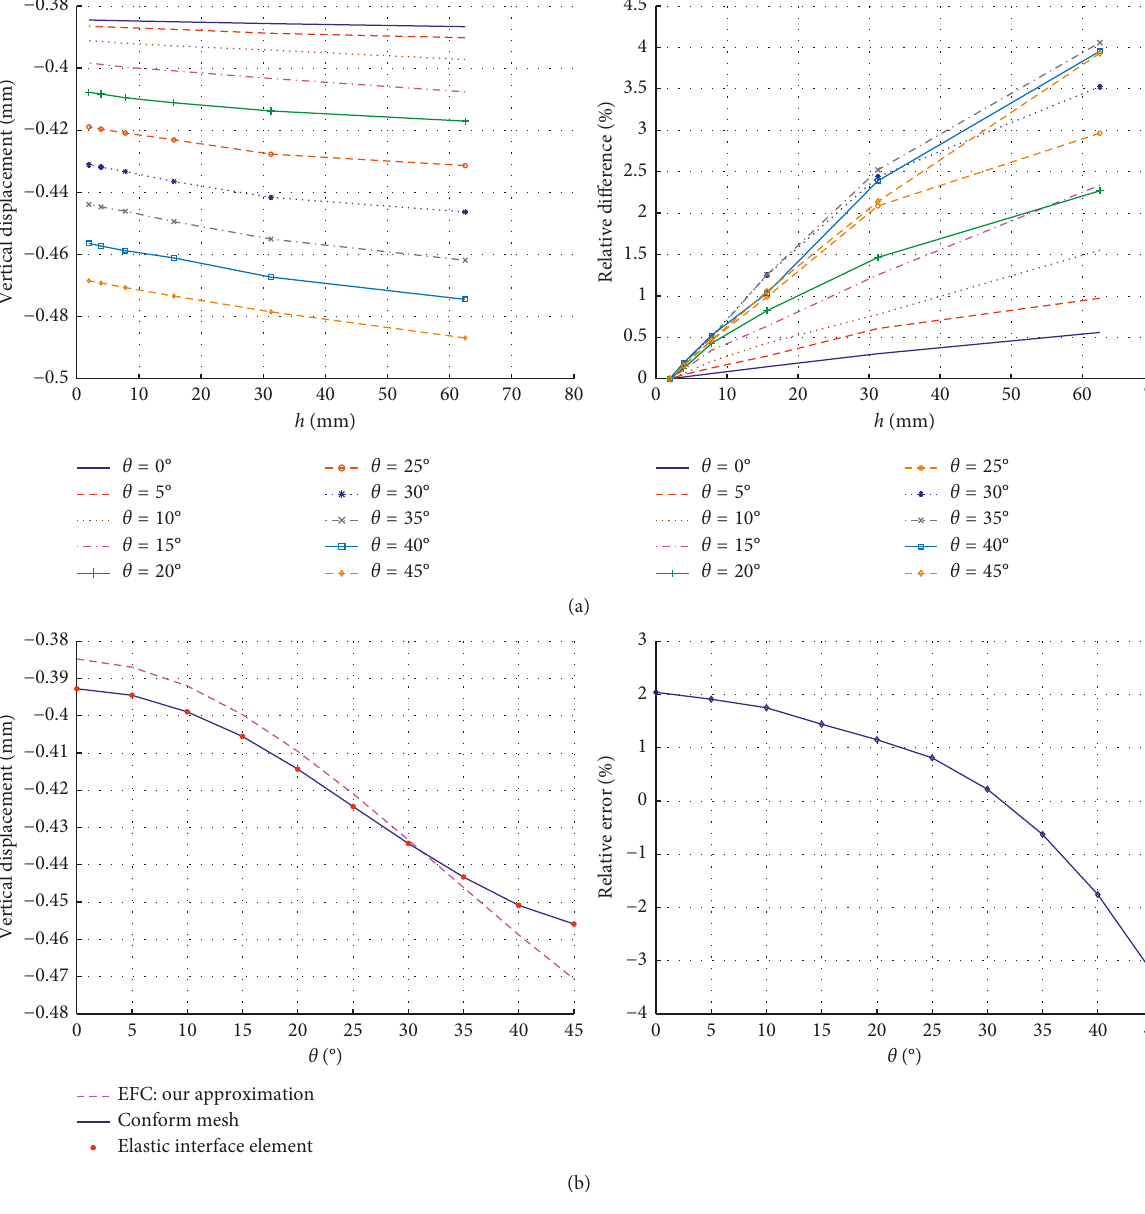
F IGURE 8: Vertical displacement at the controlled point “A” with respect to the size of the fracture cell (a) and in comparison with the referent results (using the interface element model or conformed mesh model) and the results calculated from the EFC using the nonuniform model based on the local refinement technique